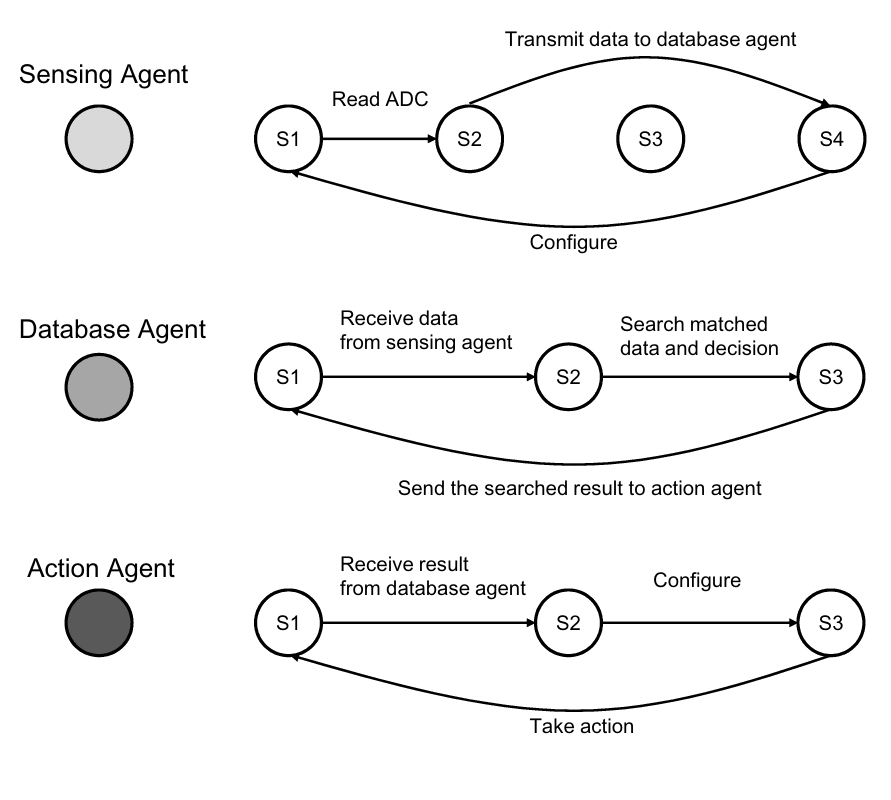
Figure 12. The finite state machines for each agent under the energy-efficient- oriented